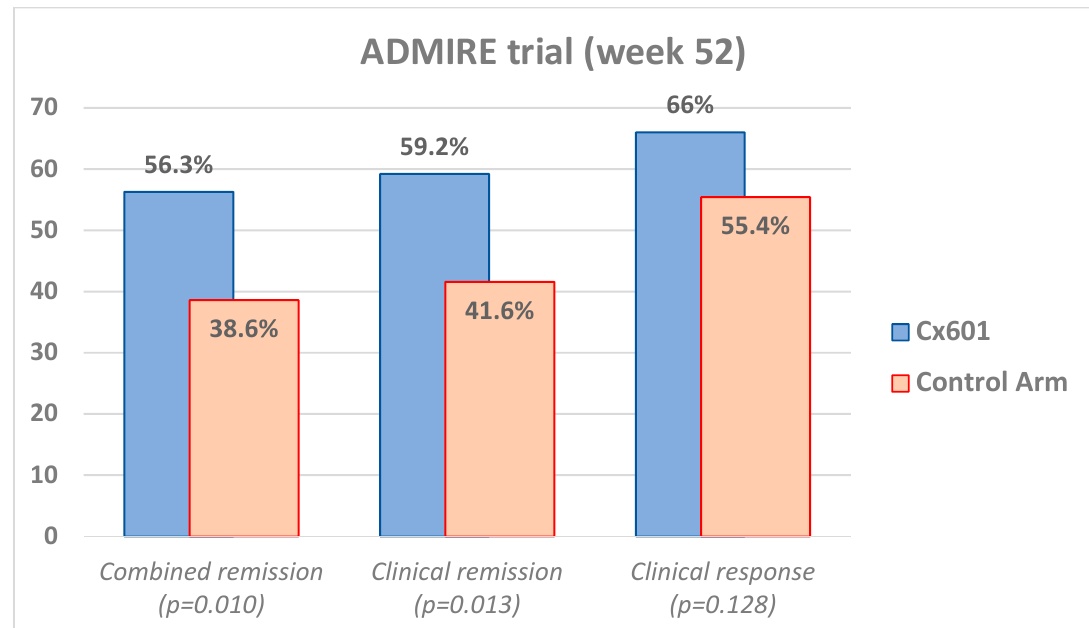
Figure 3. Long-term extension efficacy results of the ADMIRE randomized trial at week 52.